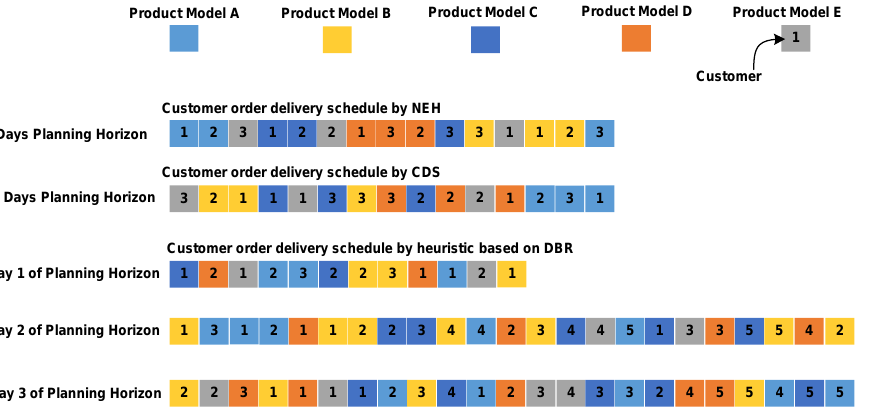
Figure 4. The scheduling results of the product models for each customer based on NEH, CDS, and heuristic based on the DBR method.